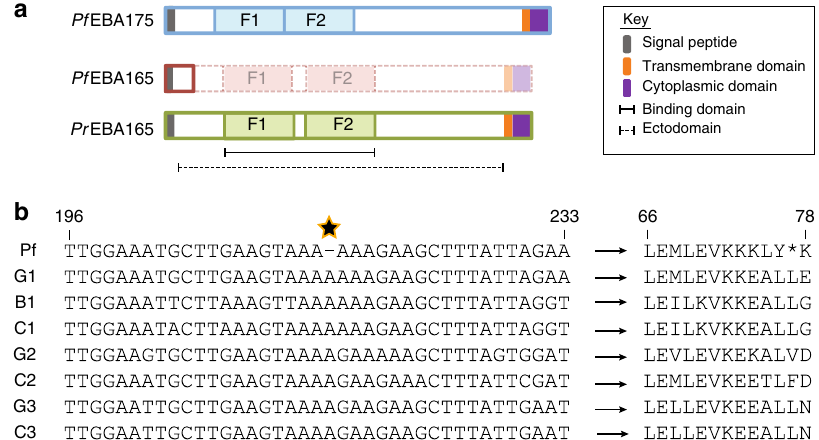
Fig. 1 EBA165 frameshifts are speci fi c to human-infective Laverania parasites. a Cartoon of EBL protein structure and domains. The erythrocyte binding domain of each protein is split into two Duffy Binding Like (DBL) erythrocyte binding domains (F1, F2). Bold outlines indicate translated amino acid sequence. In P. falciparum , the presence of a frameshift mutation eliminates translation of the majority of the protein, including both DBL domains, unlike the homologous protein in Plasmodium reichenowi (PrEBA165) or the major P. falciparum glycophorin binding protein, PfEBA175. The dashed/faded region of PfEBA165 depicts the protein structure that would be produced if frameshifts are corrected. b Alignment of Laverania EBA165 orthologues spanning the single base pair deletion (starred) universally conserved in 2517 globally distributed clinical P. falciparum isolates. Sequences displayed are from one isolate for each Laverania species (G1, P. praefalciparum ; C1, P. reichenowi ; B1, P. lomamiensis ; G2, P. adleri ; C2, P gaboni ; G3, P. blacklocki ; C3, P. billcollinsi ). All seven non-human-infective Laverania species lacked the single nucleotide deletion (left hand side), eliminating the premature stop codon present in PfEBA165 and resulting in intact amino acid sequences (right hand side). Residue numbers are indicated above the alignments and are based on the PfEBA165 sequence. Partial alignments of ape Laverania PfEBA165, along with a frameshift corrected P. falciparum sequence, are shown in Supplementary Fig.